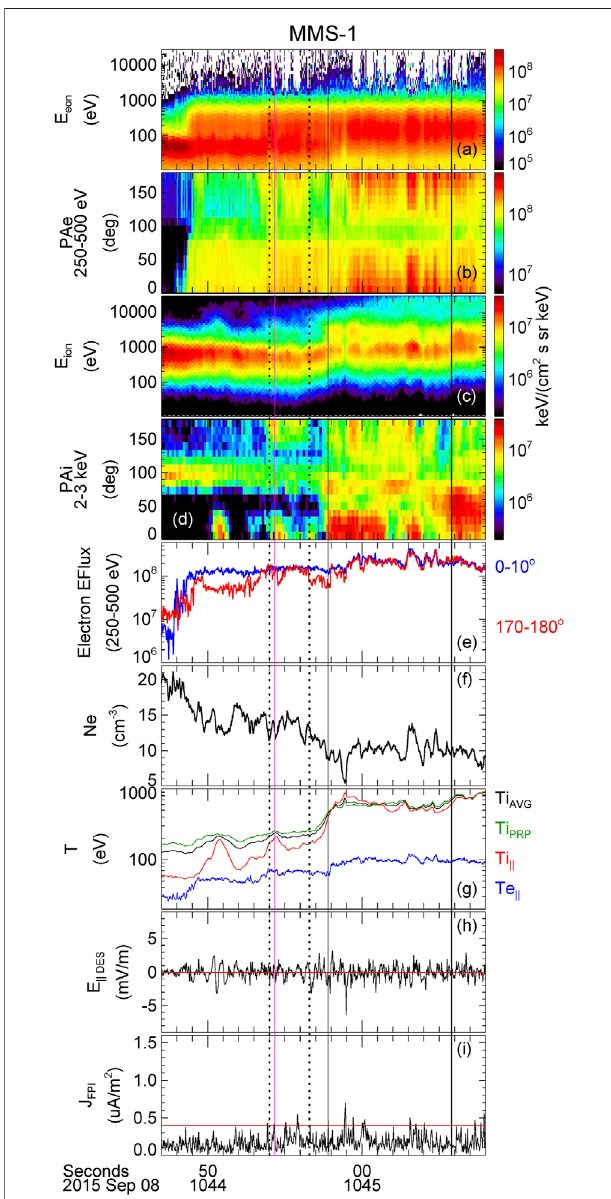
FIGURE 12 | MMS-1 burst observations from 1044:47 UT to 1045:08 UT. Same panel format as described in Figure 8 . Two vertical dotted lines mark the time period from 1044:54.000 UT to 1044:56.600 UT when (Vernisseetal.,2016)indicatedapresenceoftwocounter-streamingion beams. Apinksolidverticallinemarksthetime1044:54.349UToftheMMS-1 ionVDFdisplayedin Figures13A,D .Thetwoblacksolidverticallinesat1044: 57.800 UT and 1045:05.800 UT marks an interval with a characteristic warm ion temperature 450 eV < Ti AVG < 800